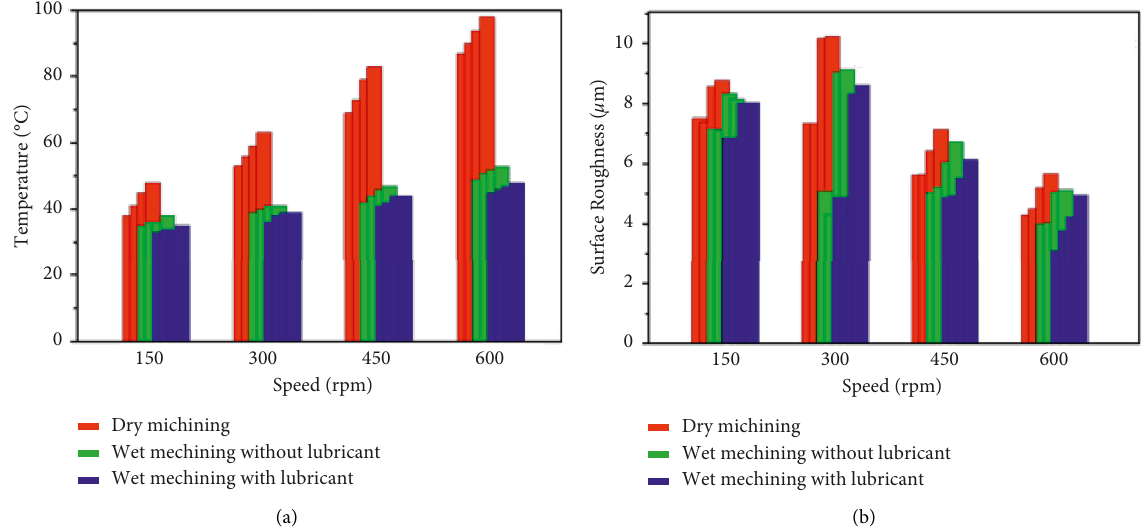
Figure 7: Comparison of (a) temperature versus cutting speed and (b) surface roughness versus cutting speed at different levels of machining